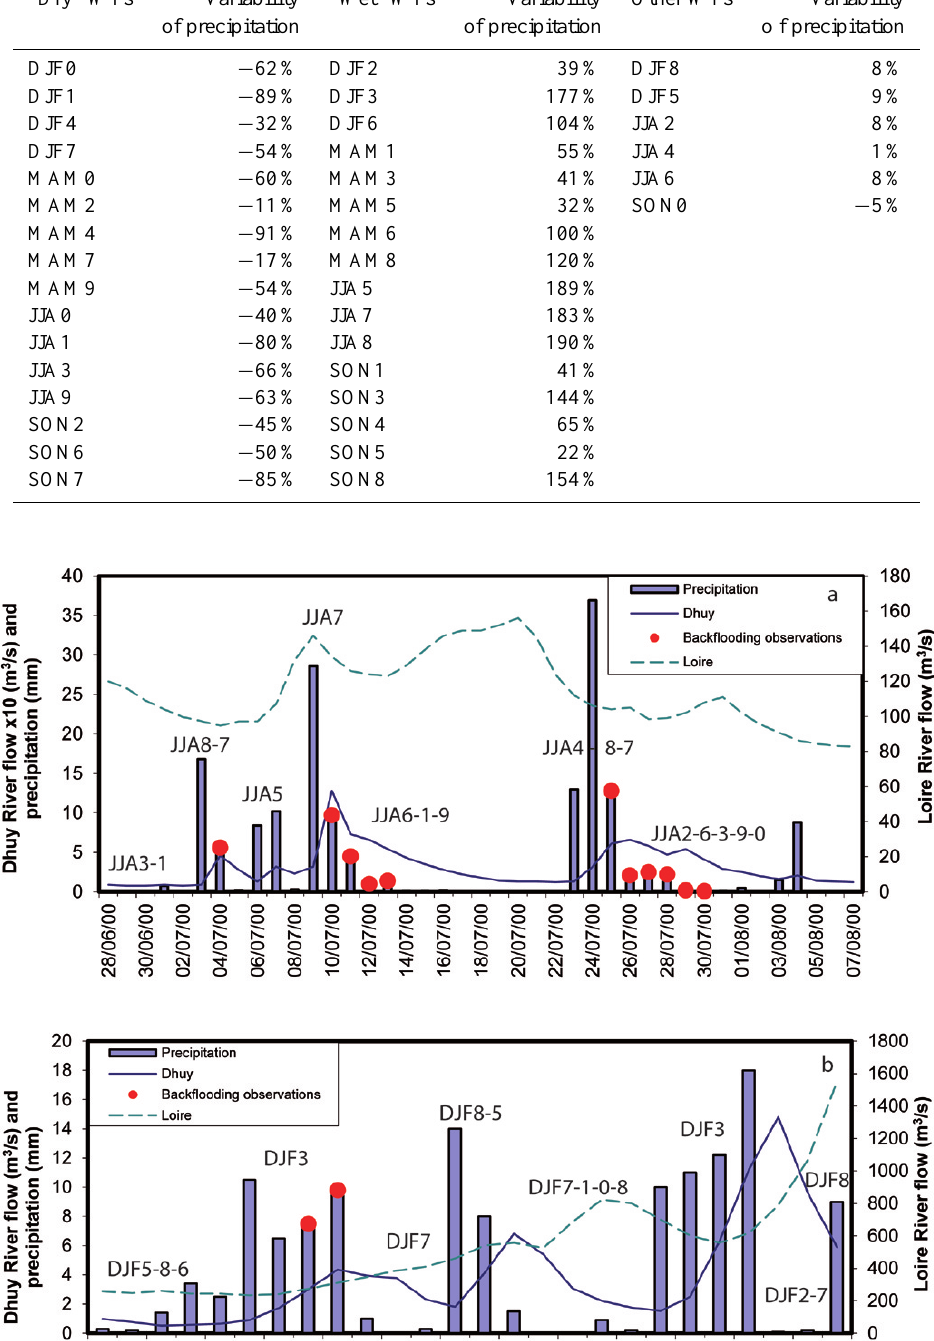
Table 1. Precipitation variability of each WT according to the seasonal precipitation rates. “Dry” WTs Variability “Wet” WTs Variability Other WTs Variability of precipitation of precipitation o f precipitation